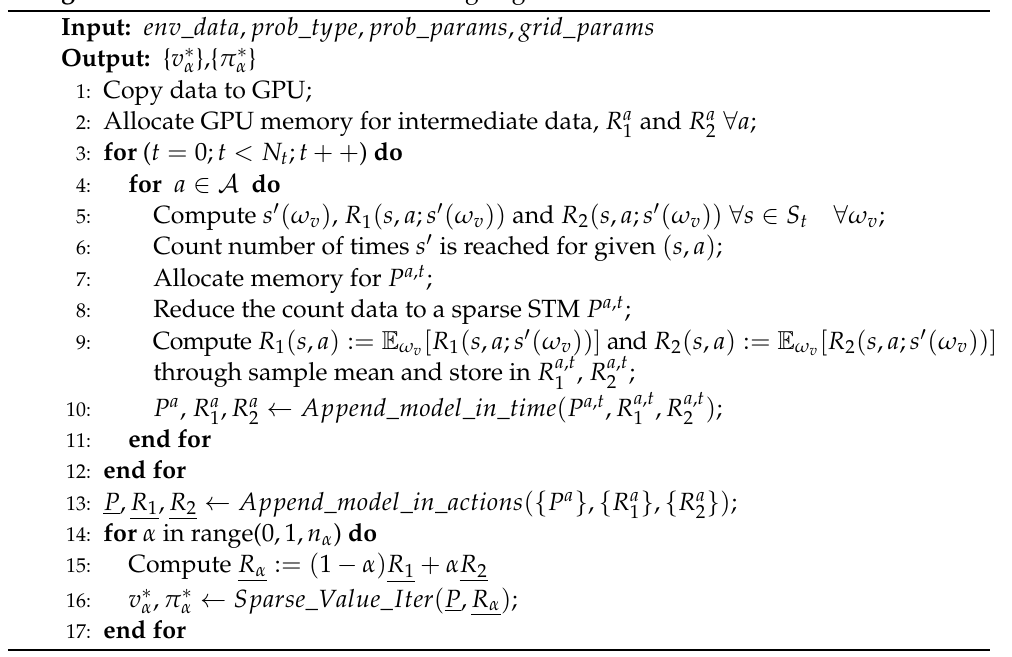
Algorithm 1: GPU Accelerated Planning